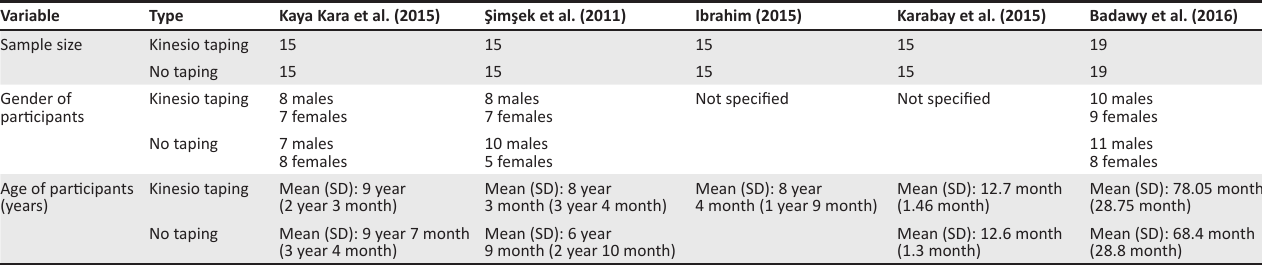
TABLE 2: Description of the included studies’ sample